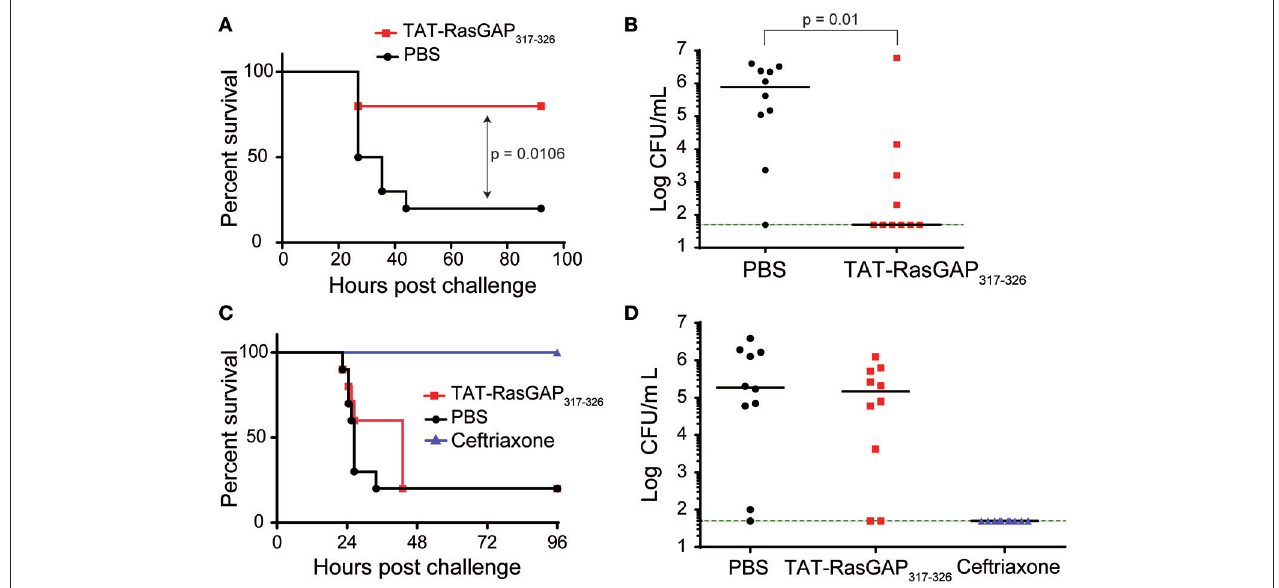
FIGURE 6 | TAT-RasGAP 317 − 326 can protect from E. coli peritonitis. (A–D) BALB/c mice (10 per group) were injected i.p. with 1.1 × 10 5 CFU E. coli O18 and 2min (A,B) or 2 h later (C,D) with PBS, 1 mg/kg TAT-RasGAP 317 − 326 or 4mg/kg ceftriaxone. (A,C) Survival of mice. (B,D) Bacterial counts in the blood 24h post-infection. The green dashed line indicates the limit of